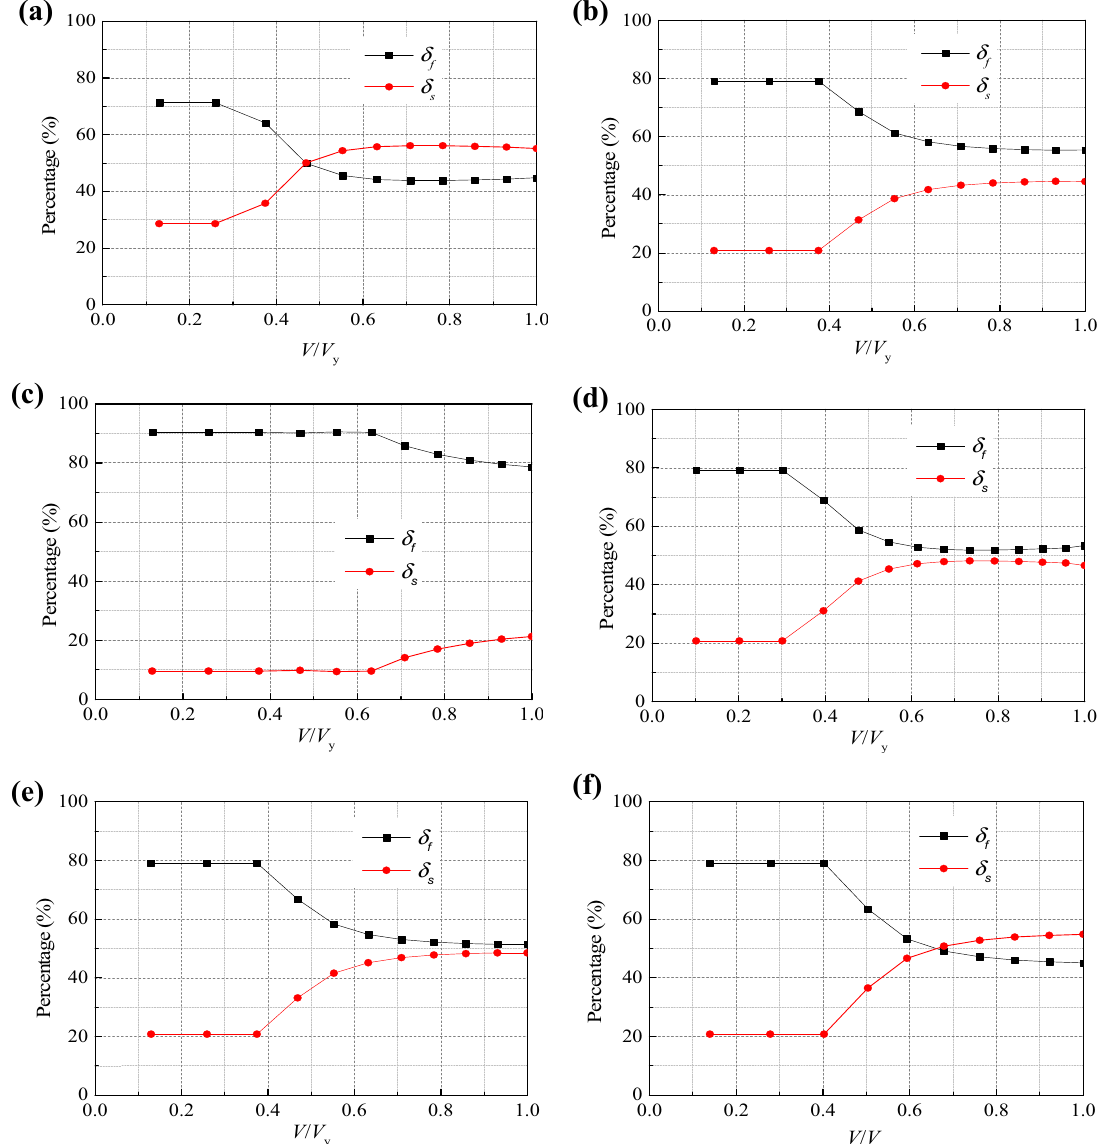
Fig. 11 Percentage of flexural and shear deformations before yielding of RECC columns. a Specimen E1, b Specimen E2, c Specimen E3, d Specimen E4, e Specimen E5 and f Specimen